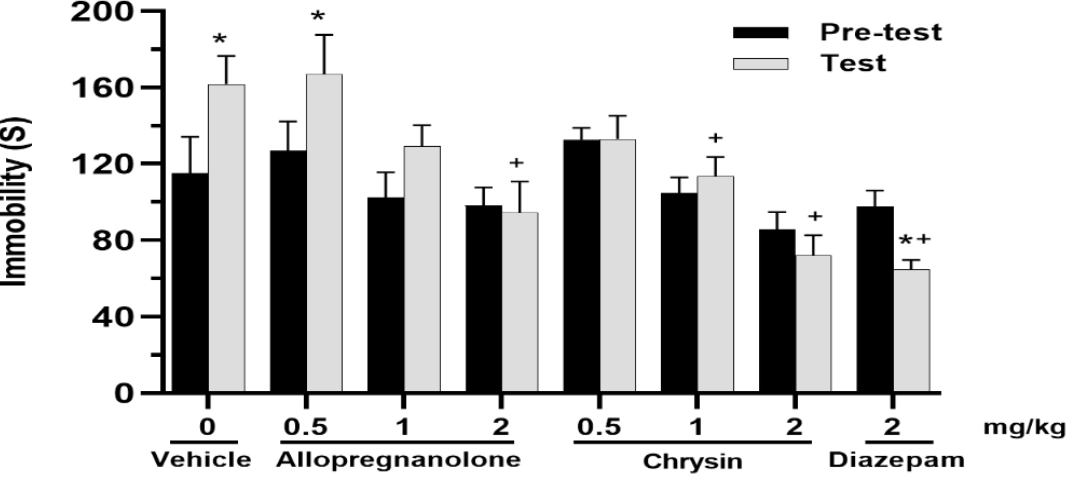
Figure 1. Total time of immobility. Immobility increased from pre-test to test session in vehicle and allopregnanolone (0.5 mg/kg) groups, while no changes were detected in allopregnanolone (1 and